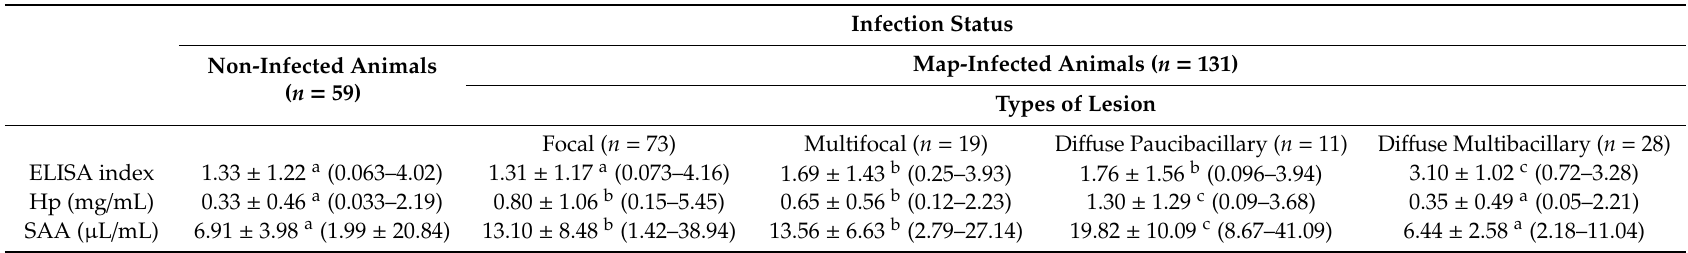
Di ff erent superscripts within each row indicate statistically significant di ff